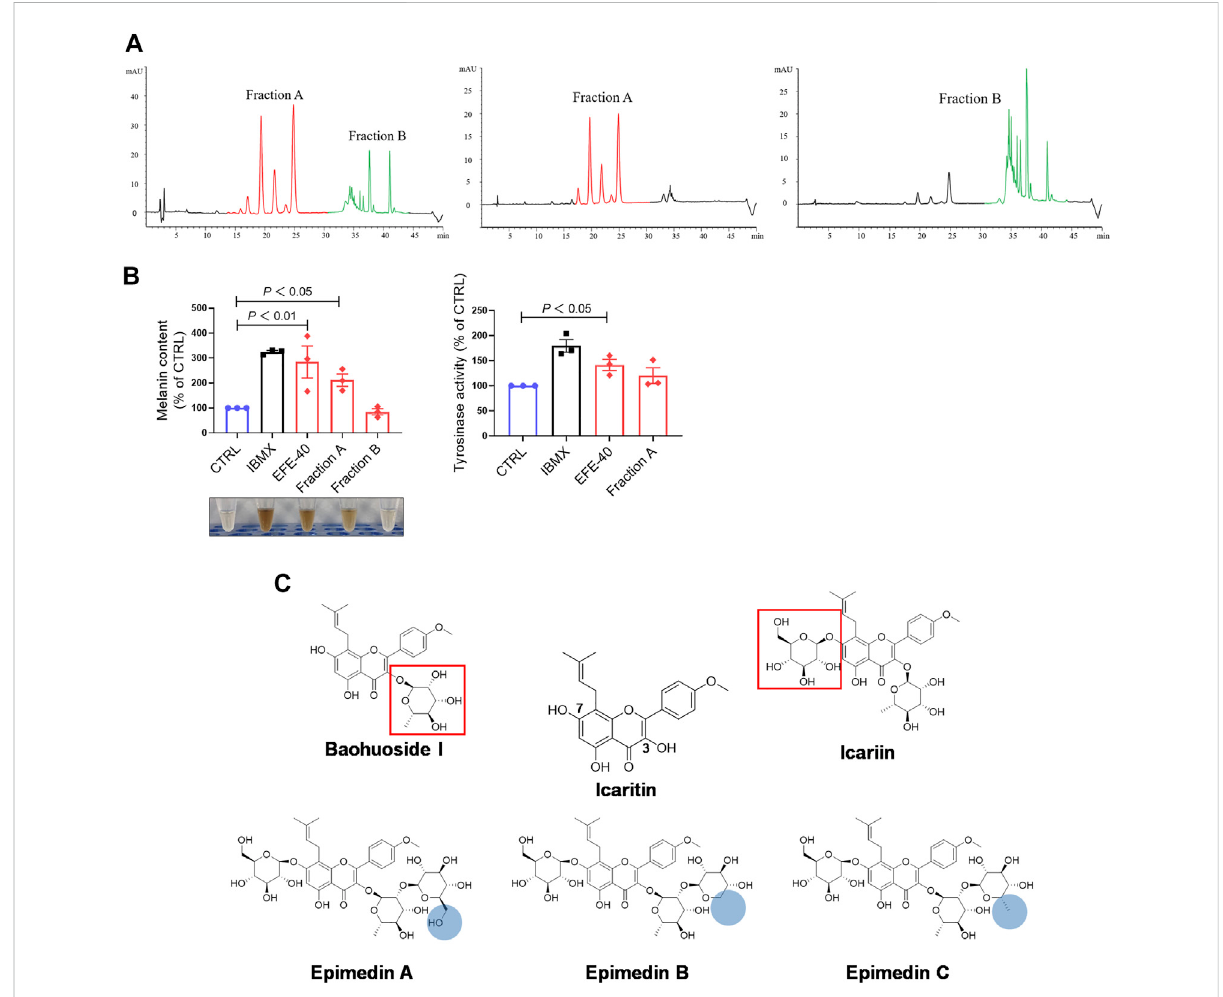
FIGURE 9 EFE ’ s fi ngerprint, main compounds ’ identi fi cation, and epimedin B as a high-content, low-toxicity, and effective compound in melanogenesis. (A) High-performanceliquidchromatographypro fi lesofEFE,fractionA,andfractionB; (B) melanincontent,melanincolor,andtyrosinaseactivityon B16F10 cells (faction A and B: 40 μ g/ml, 72 h); (C) structural differences of fi ve main components and icaritin. For graphical representation, data are presented as mean ± SEM ( n ≥ 3 in each group), p < 0.05, p < 0.01, and p < 0.001 vs. CTRL are considered signi fi